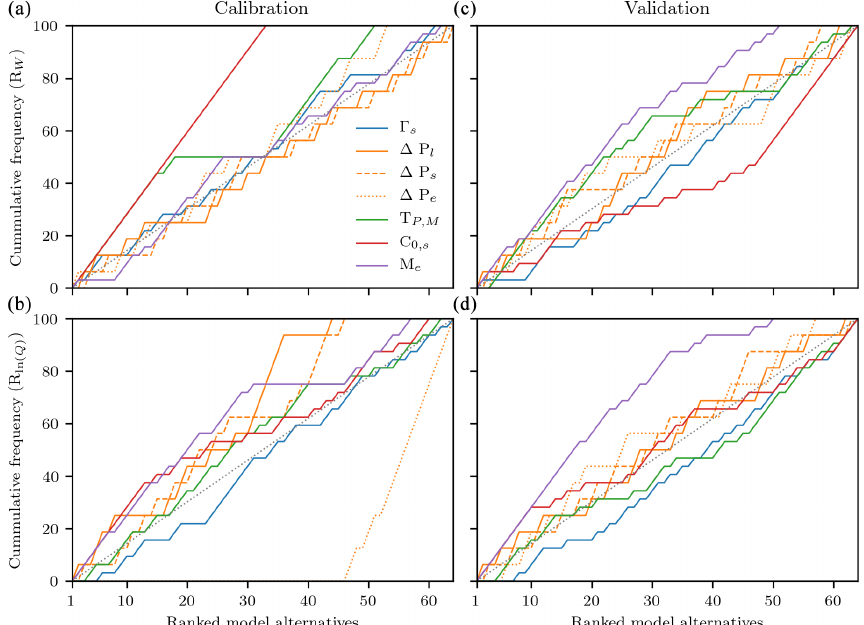
Figure 8. Cumulative plots for each of the seven individual modifications to the snow routine of the HBV model as a function of the ranked 64 model structures arising from all the possible combinations of modifications. The modifications are a seasonally variable temperature lapse rate ( (cid:48) s ), a linear, sinusoidal, and exponential function for the precipitation phase partition ( (cid:49)P l , (cid:49)P s , and (cid:49)P e respectively), different thresholds for precipitation phase and snowmelt ( T P , M ), a seasonally variable degree-day factor ( C 0 , s ), and an exponential snowmelt with no refreezing ( M e ). Model simulations against snow water equivalent are presented in (a, c) , while those against logarithmic stream runoff are presented in (b, d) . Model calibration is presented in (a, b) and model validation in (c, d) . Model modifications plotted above the 1:1 line (grey dotted line) tend to be included in high-ranking model structures, while those plotted below the 1:1 line tend to be included in low-ranking structures.